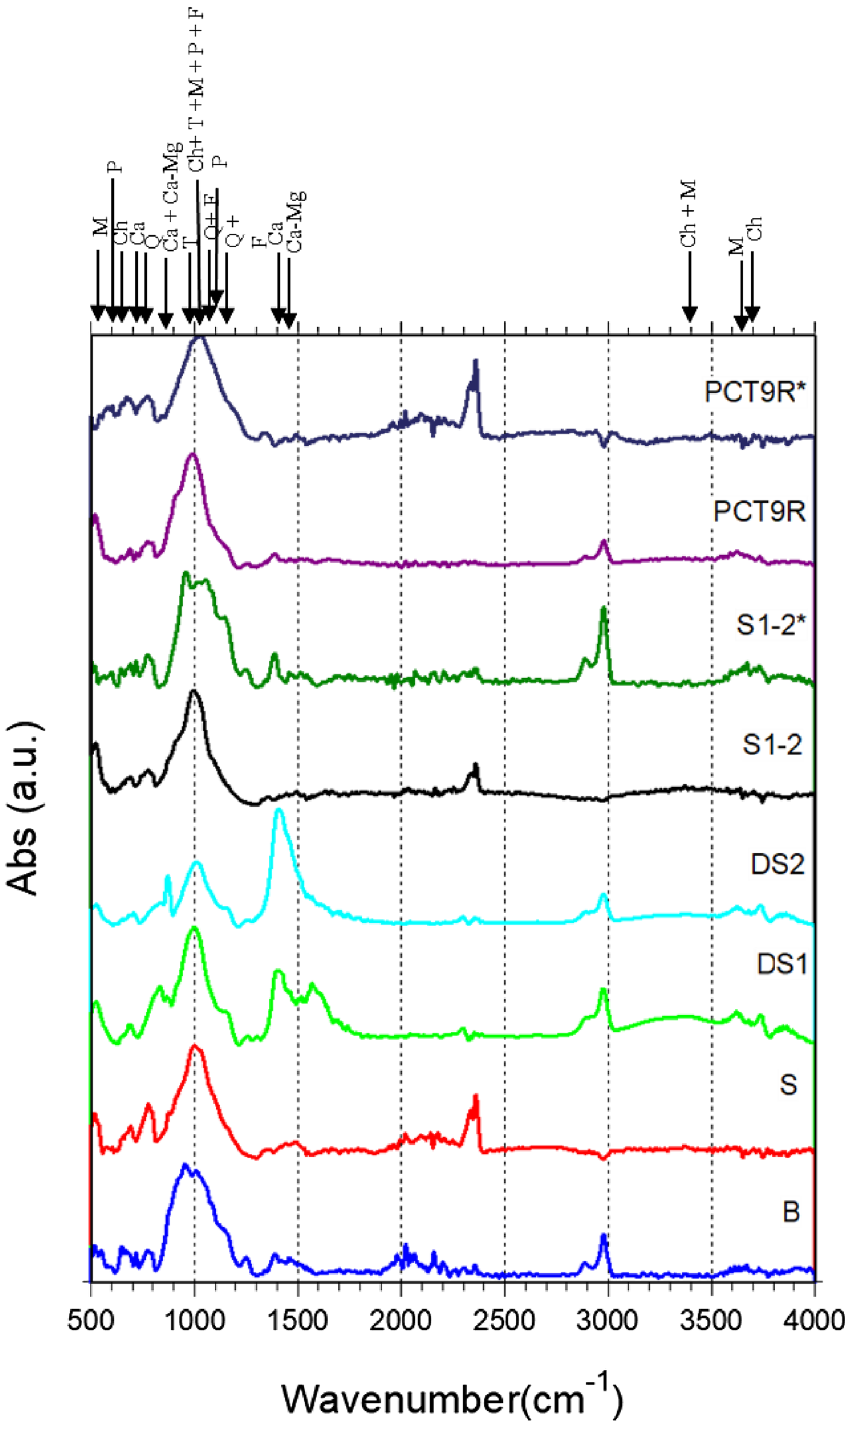
Figure 4. FT-IR spectra of investigated samples (see Table 1 for sample notation). Note: (asterisk) powder samples ignited at 880 °C with a heating rate 200 °C/h, and for a 1 h dwell time. The notation for the mineral phases identified is the same as in Fig. 3. For details of identified minerals see Supplementary material Table